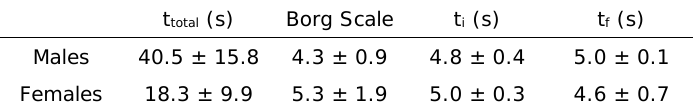
Table 3. Total time, Borg Scale, initial and final movements time